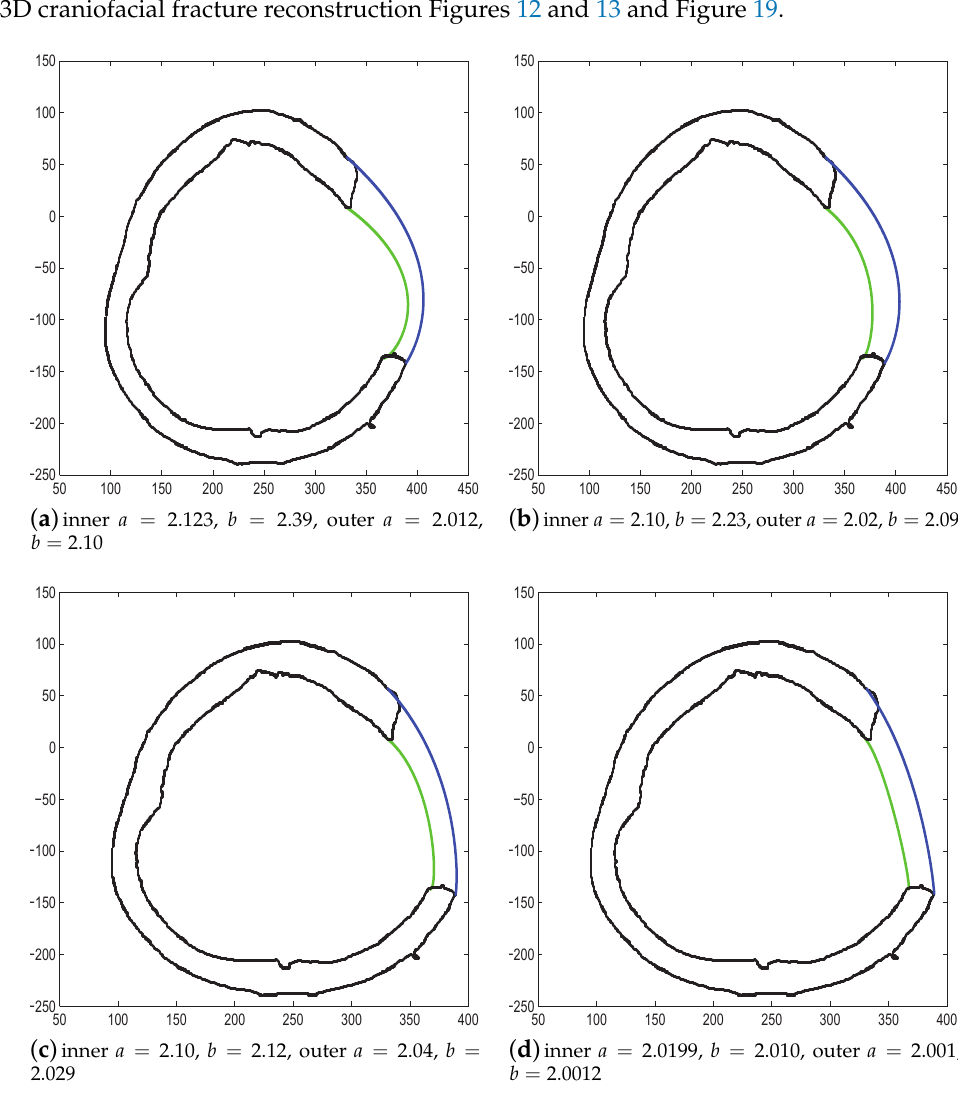
Figure 17. Effect of shape parameters.